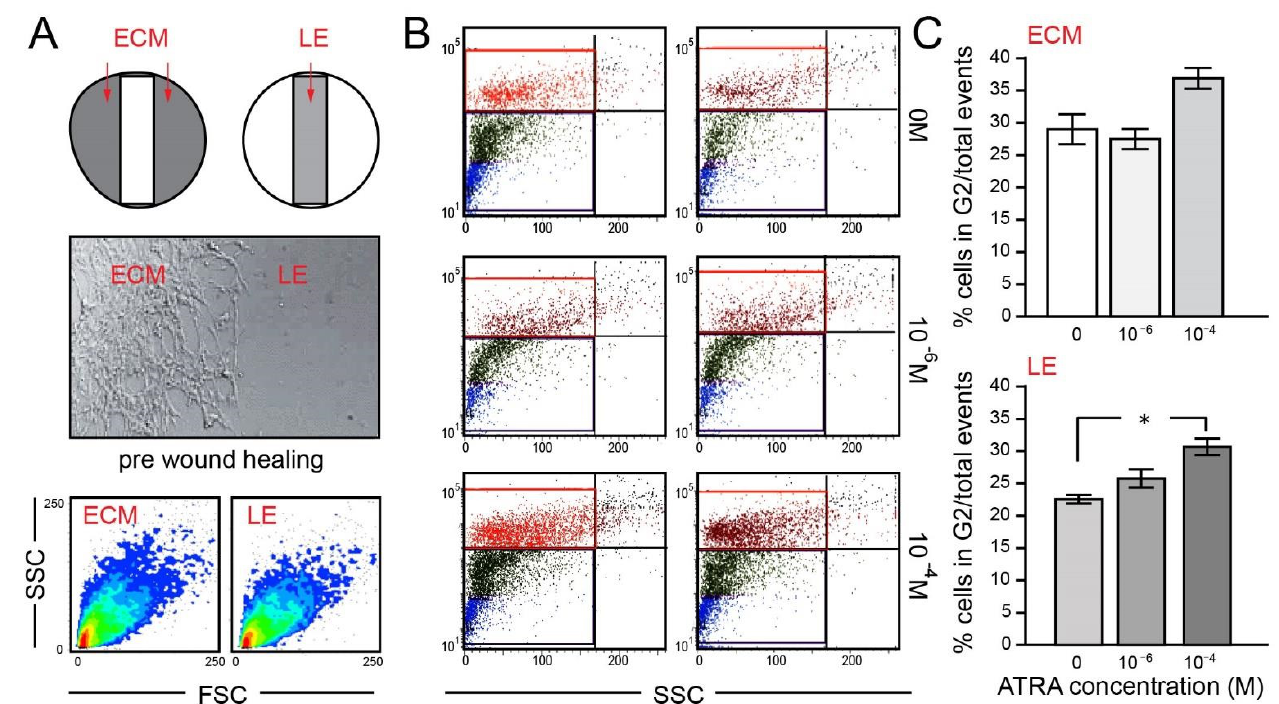
Figure 3. ATRA influences U87MG proliferation only in the leading edge. Schematic of the location of the established cellular monolayer (ECM) and leading edge (LE) zones in a tissue culture in vitro environment post wound formation ( A ); upper). Confocal micrograph of U87MG cells in the ECM and LE before would healing ( A ); lower). Dot blot density cytogram of side scatter (SSC) versus forward scatter (FSC) of U87MG in the ECM (left) and LE (right), providing an indication of the size and granularity of cells respectively. The red/yellow/green/blue hot spots represent increasing numbers of events resulting from discrete cell populations (( A ); bottom). Side scatter plot of Click-iT Plus EdU AlexaTM 647 fluorescence incorporated cells in ECM and LE zones plus / minus ATRA with gating to demarcate the population in G2 growth phase (upper left (UL); red). Populations in G1 and S phase are indicated in blue and green respectively ( B ). Histograms showing the percentage of cells in G2 per total events (assessed cell population) indicating significance of ATRA (10 −4 M) in U87MG cells in the LE zone. Asterisk represents p < 0.05 significance, n = 3, ( C ).